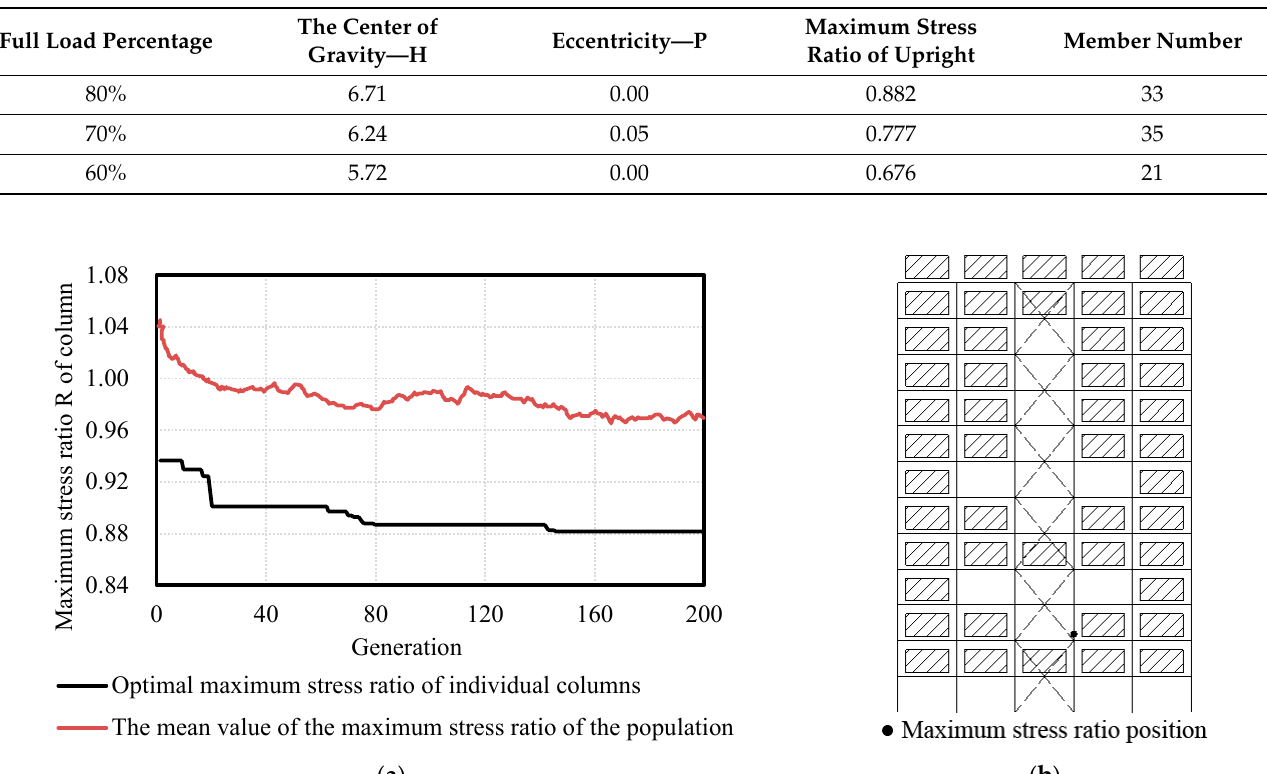
Table 4. Parameters related to the most favorable distribution patterns of the optimized loads.